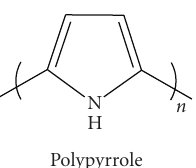
Figure 13: Chemical structure of